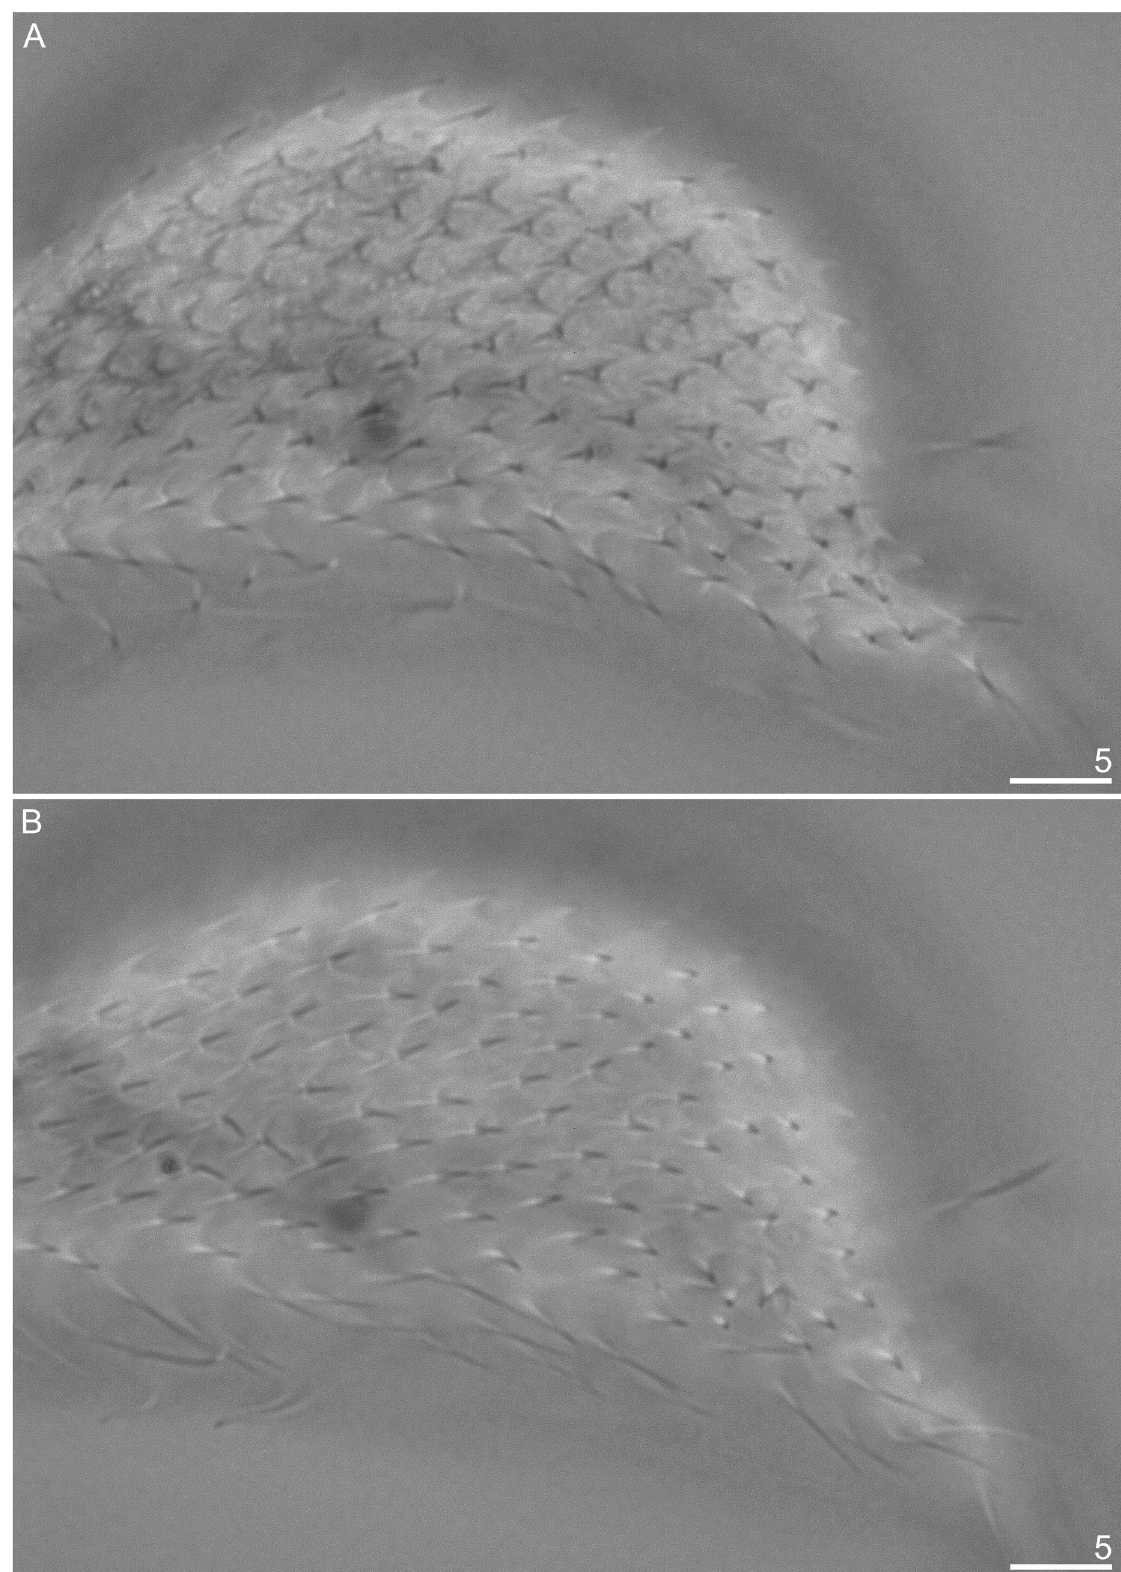
Fig. 9. Chaetonotus (Chaetonotus) antrumus Kolicka sp. nov., bright field microphotographs. A . Lateral view of scales on trunk. B . Lateral view of spines on